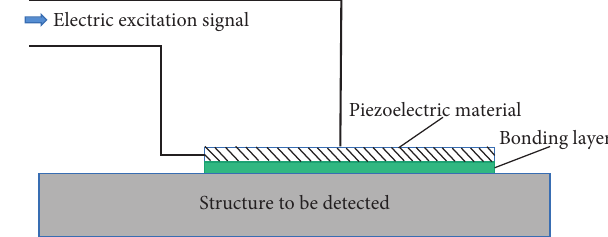
Figure 9: Principle of piezoelectric impedance detection technology. Table 1: Summary of nondestructive testing